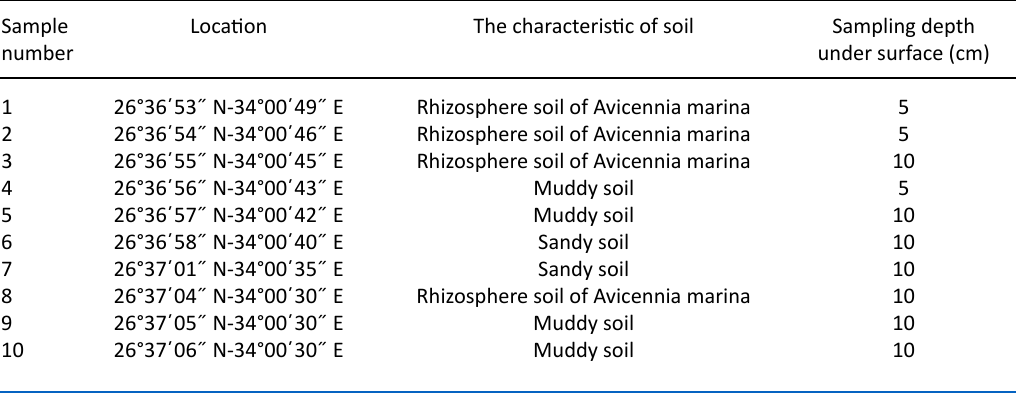
Table 1. Locations and Information of soil samples Sample Location The characteristic of